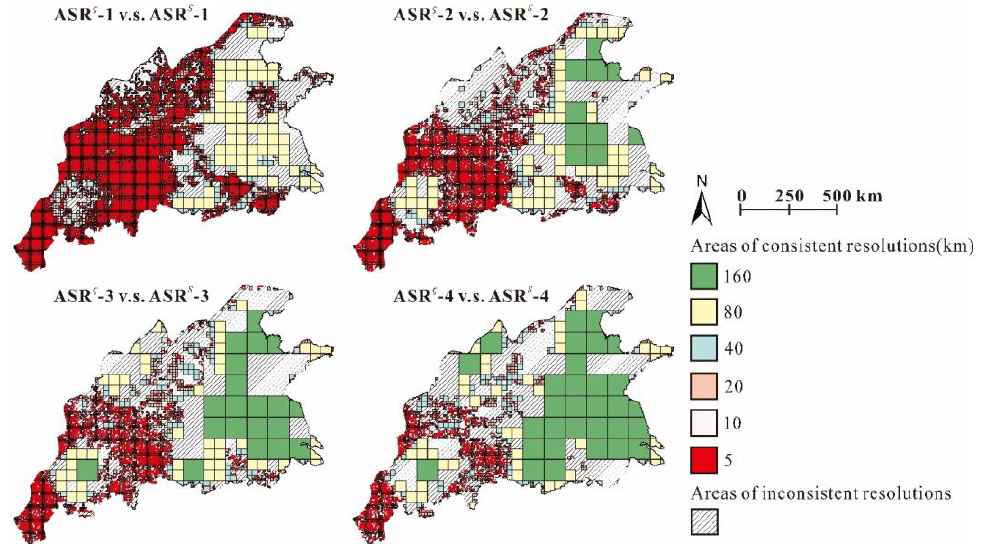
Figure 11. Contrast of the distribution of appropriate spatial resolution of the meteorological data obtained based on the scale effect index S and the sill value ς of the DEM semi-variogram. Table 4. Kappa consistency test of the appropriate spatial resolution obtained by the threshold of scale effect index S and the threshold for the sill value ς of the DEM semi-variogram: Southwest winter wheat sub-region (SWS), north winter wheat sub-region (NS), Huang-Huai winter wheat sub-region (HHS), and middle-lower reaches of the Yangzi River winter wheat sub-region (MYS). Regions Kappa Coefficient ( p < 0.05)